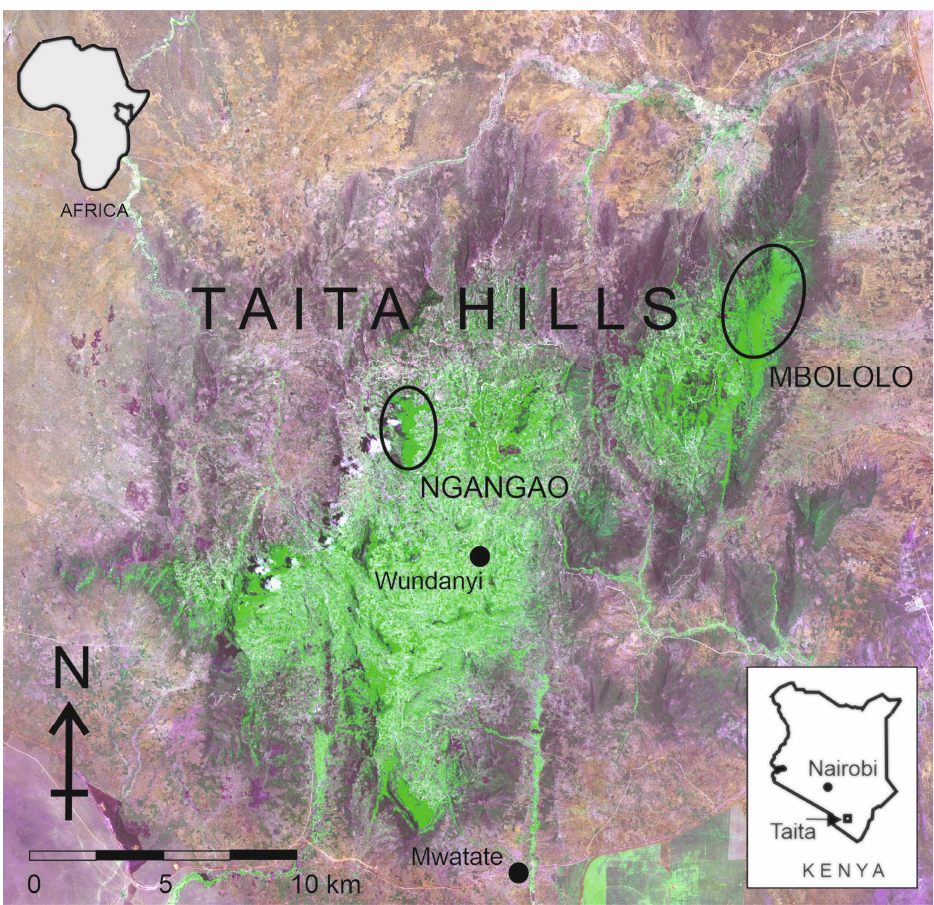
1 Figure 2. Map of the Taita Hills, Kenya, showing the locations of Ngangao and Mbololo